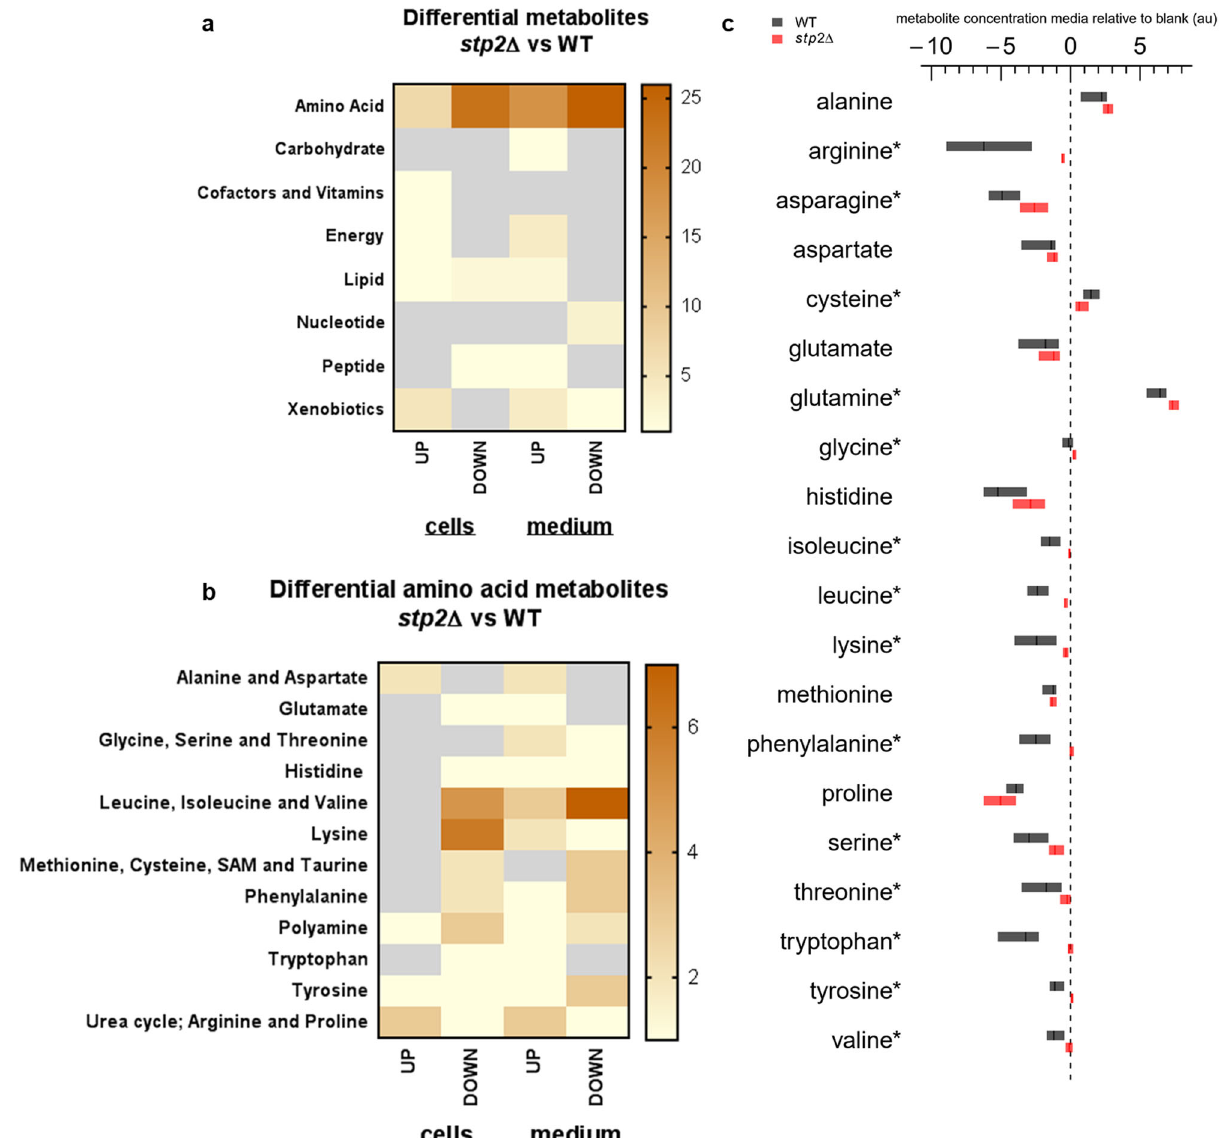
Fig. 8 Comparative intracellular and extracellular metabolomics of stp2 Δ mutant vs. wild-type bio fi lms. Metabolomes from cells and media were analyzed for signi fi cant metabolic changes in stp2 Δ mutant and wild-type bio fi lms. Analyzed contrasts were time point-adjusted. Numbers of metabolites with signi fi cant changes (Cutoff p < 0.05 and log 2 FC ± 1) were plotted for main metabolic families ( a ) and amino acids subgroups ( b ). Metabolite data were time point-adjusted (time point as a confounding variable) before comparative analysis. c Box plot diagram shows relative abundance (log 2 FC, median, upper and lower quartiles) of extracellular amino acids from wild-type (black) and stp2 Δ (red) media, which were normalized to the respective amino acid concentrations from RPMI blank medium. Statistical differences between strains were calculated using the Student ’ s t -test and plotted next to the corresponding amino acid (* for p < 0.05). Source data are provided as a Source Data fi